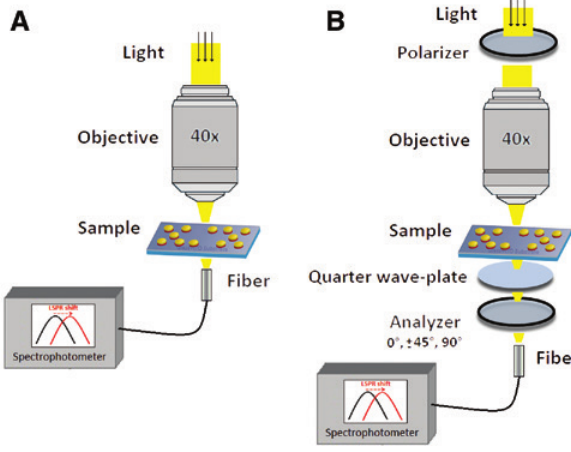
Figure 3: Representation of the experimental set up used for plas- monic measureaments. (A) Set up used to measure UV-vis extinction spectra. (B) Phase- ometry used for LOD evaluation of Thiram pesticide.